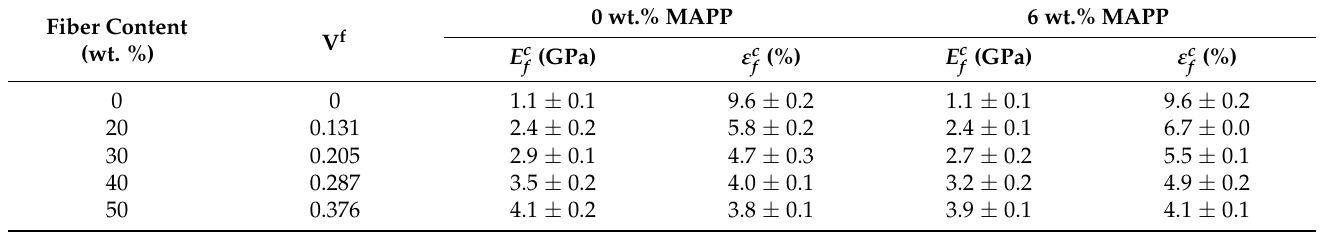
Table 2. Flexural modulus ( E C cotton fibers.